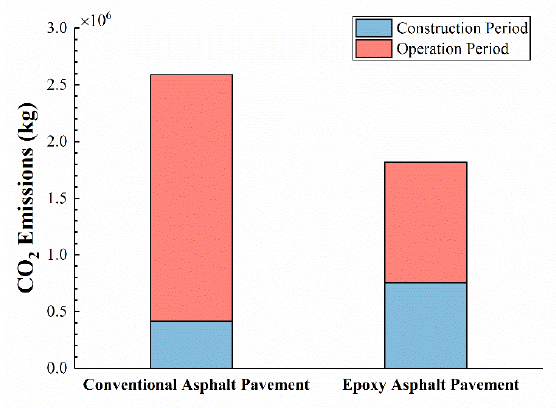
Figure 12. LCA of carbon emissions for epoxy asphalt pavement and conventional asphalt pave- ment.